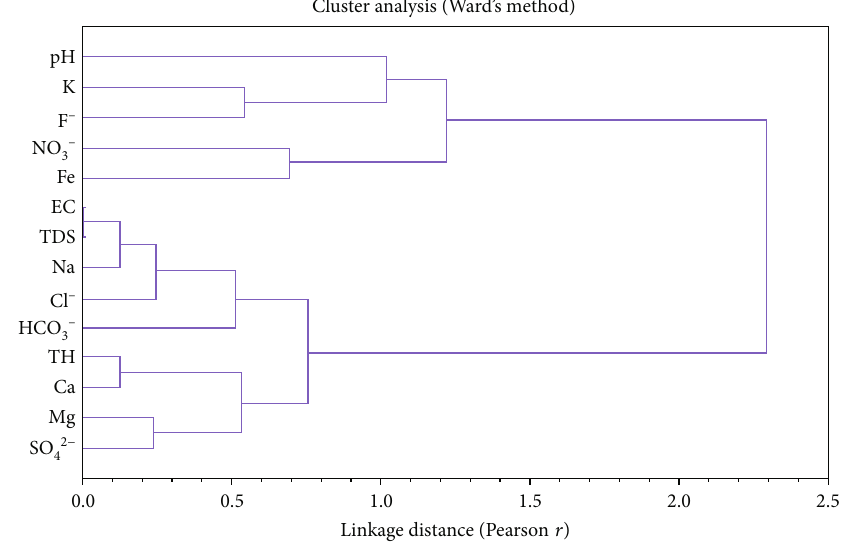
2.52.01.51.0 Figure 8: Cluster analysis of the physicochemical parameters in groundwater of the study